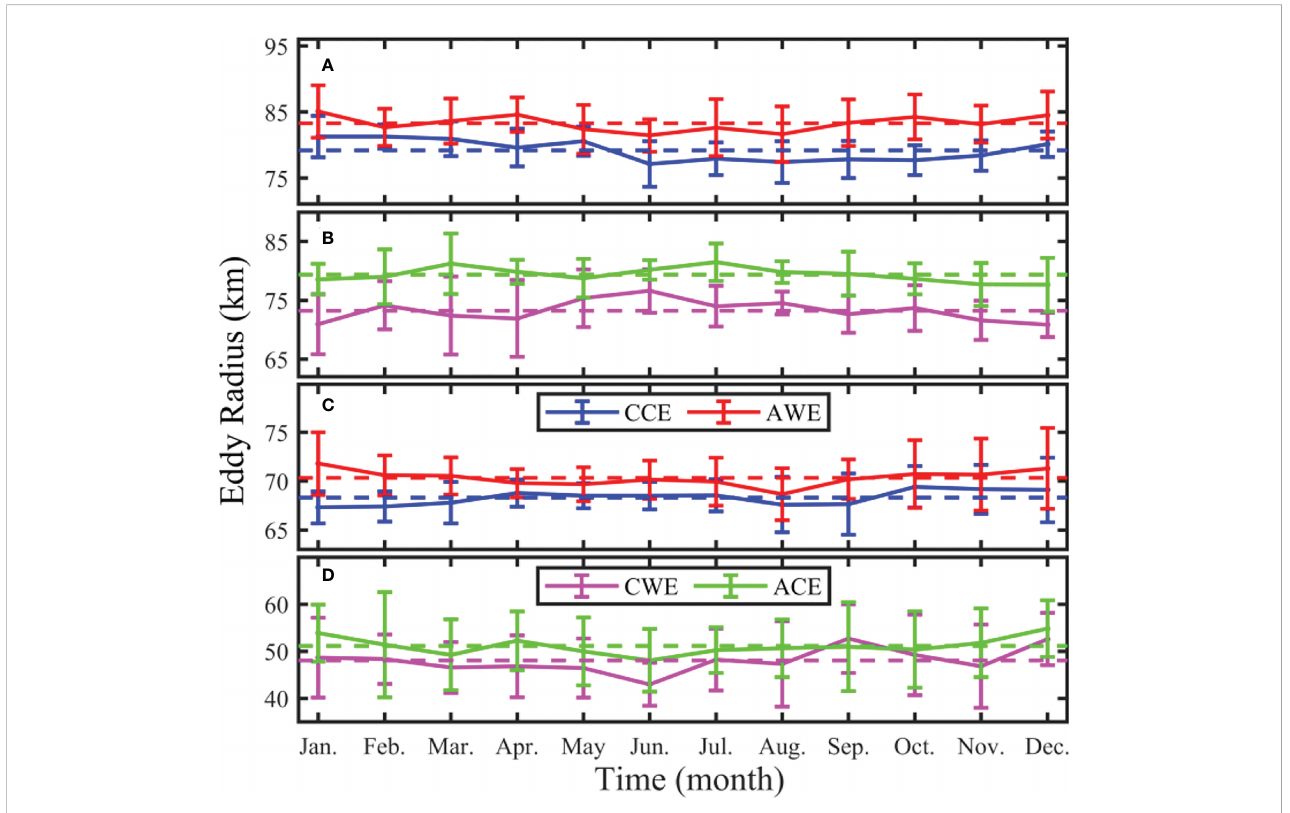
FIGURE 2 Monthly distribution of multi-year (2008 ~ 2017) average eddy radius at the sea surface (A, B) and 1,000 m (C, D) in the STCC area. Blue, red, pink, and green curves represent cyclonic cold-core eddy, anticyclonic warm-core eddy, cyclonic warm-core eddy, and anticyclonic cold-core eddy, respectively. The bar represents the standard deviation, and the dotted line represents the multi-year average